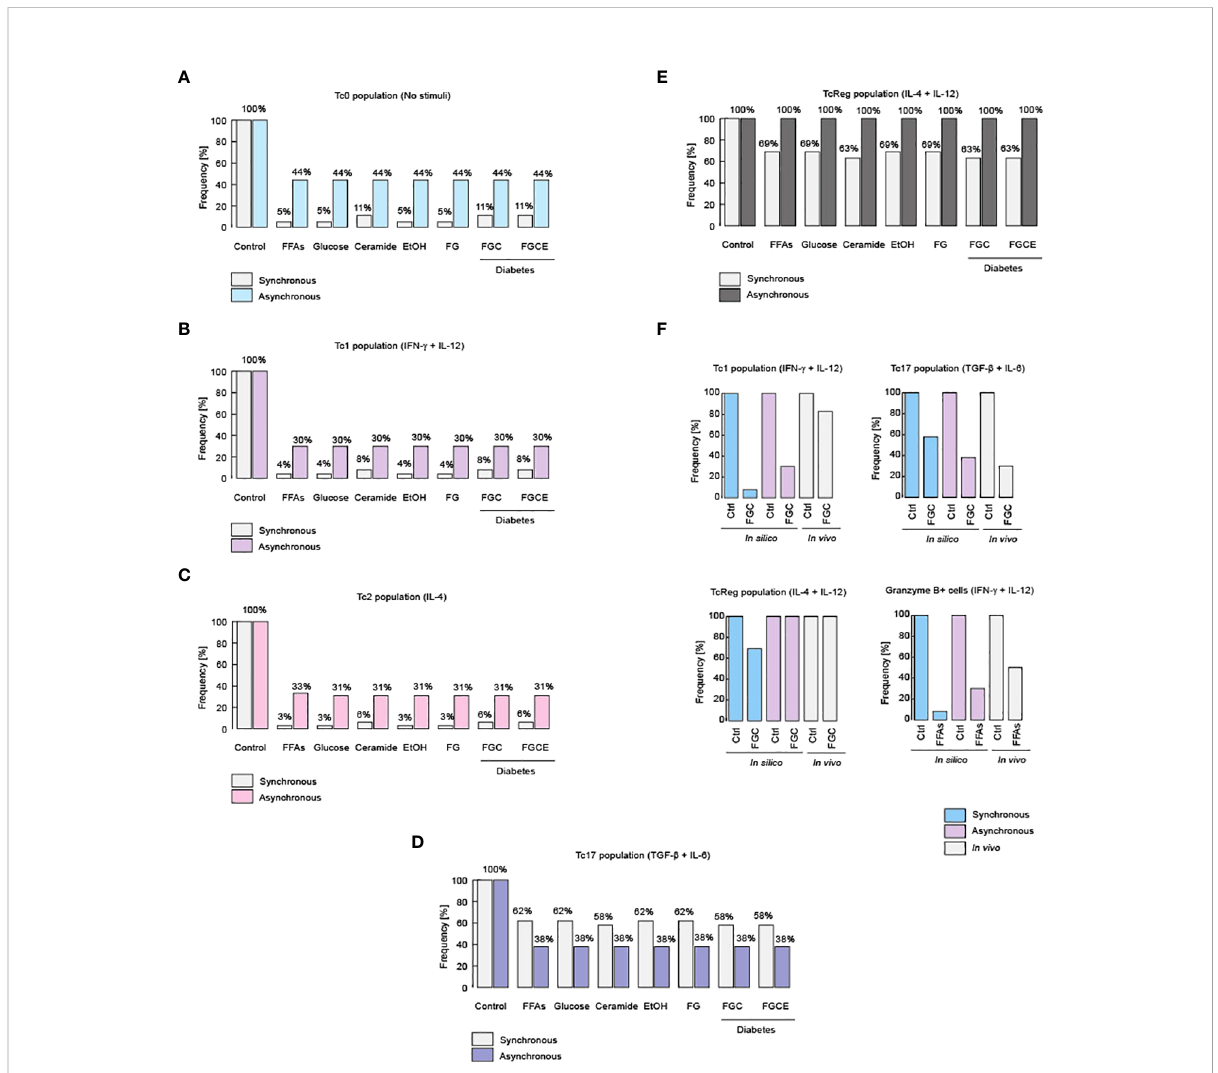
FIGURE 3 Metabolic alterations impair CD8+ T cell differentiation. Effects of different metabolic alterations such as high fat diets, high consumption of sugar and alcohol, as well as other health problems like diabetes. Metabolic alterations for the Tc0 population (A) , as well as for the Tc1 (B) , Tc2 (C) , Tc17 (D) and TcReg population (E) . (F) Experimental evidences that con fi rm these phenotypic alterations for Tc1, Tc17 and TcReg cells, as were described for healthy and diabetic patients